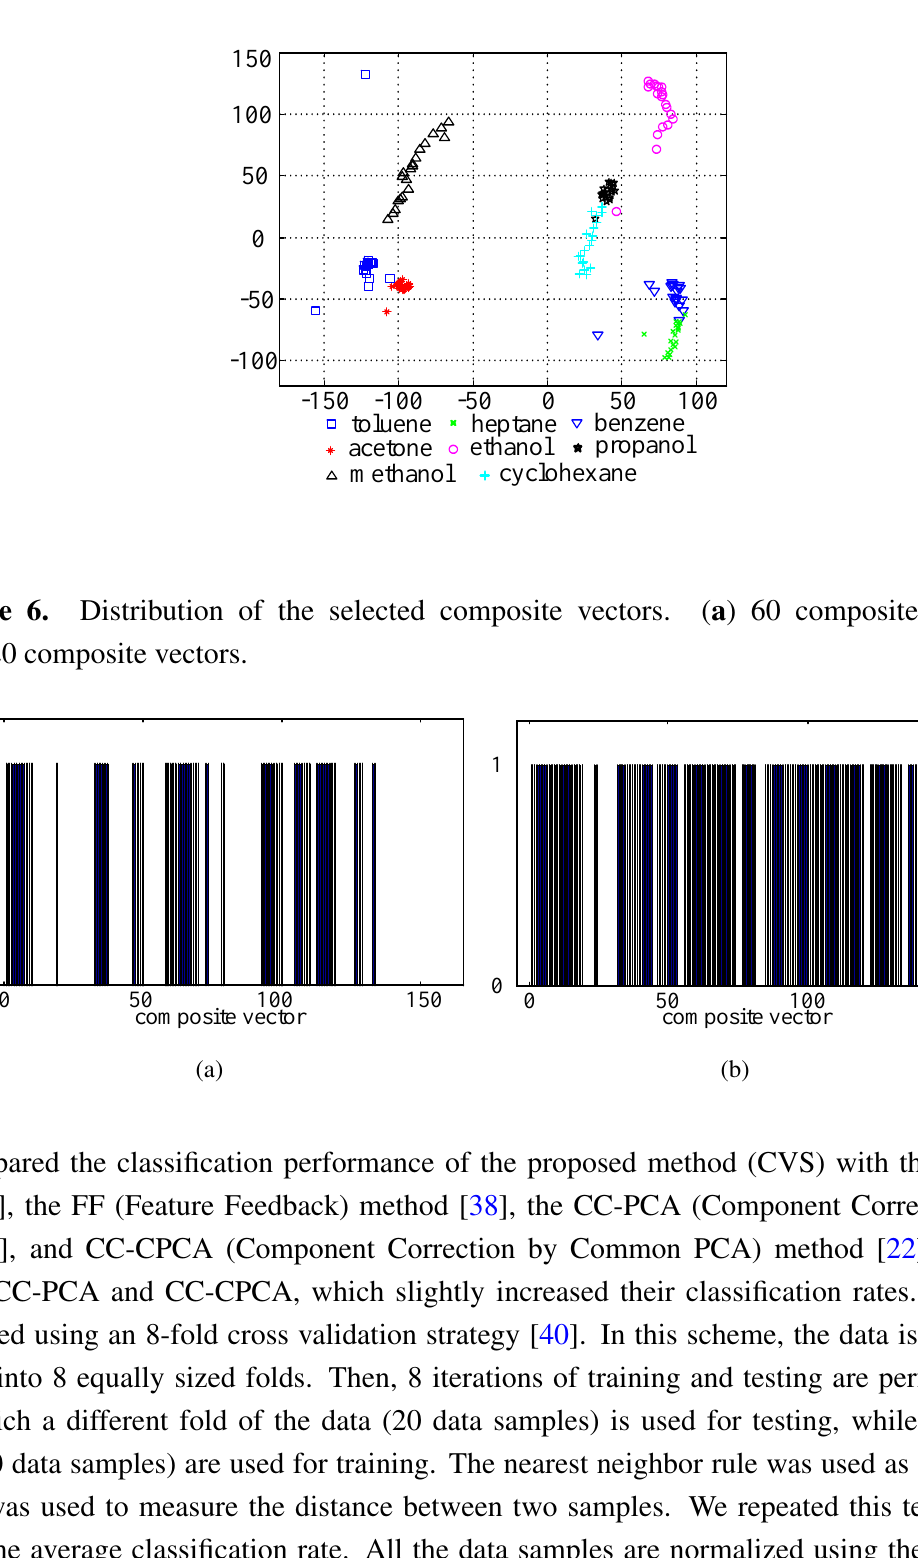
Figure 5. Distribution of the data samples in the Principal Component Analysis (PCA) feature space.